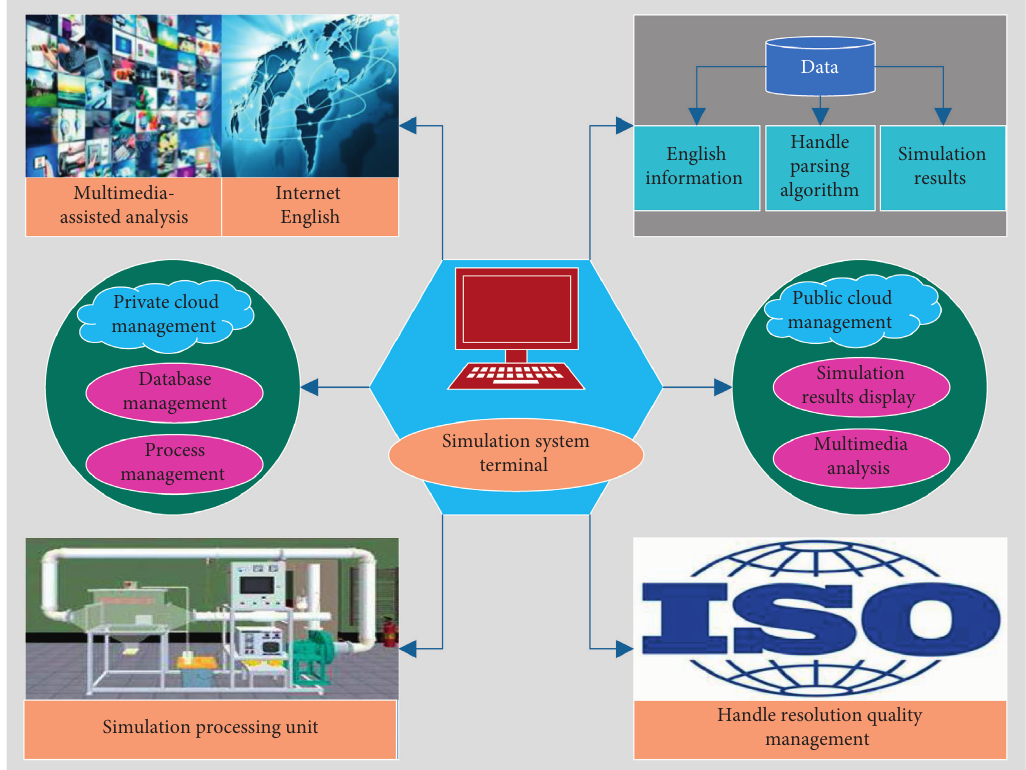
Figure 2: Multimedia English auxiliary handle parsing simulation system